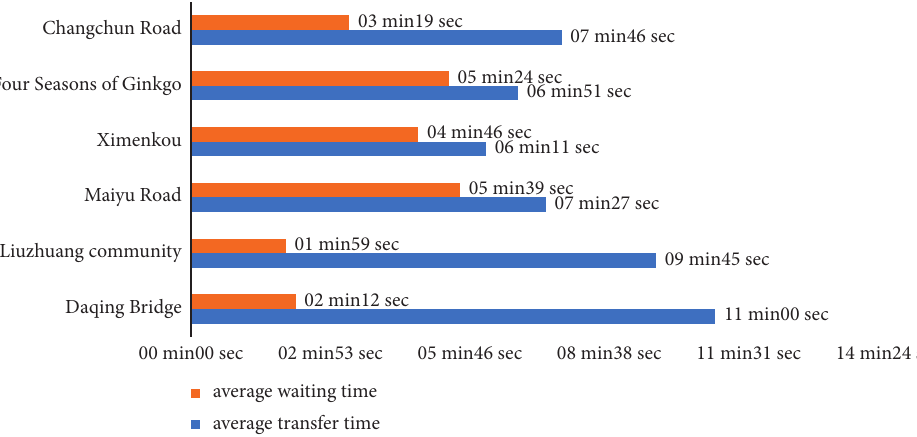
Figure 7: Transfer time and waiting times of bus stops around Ximenkou